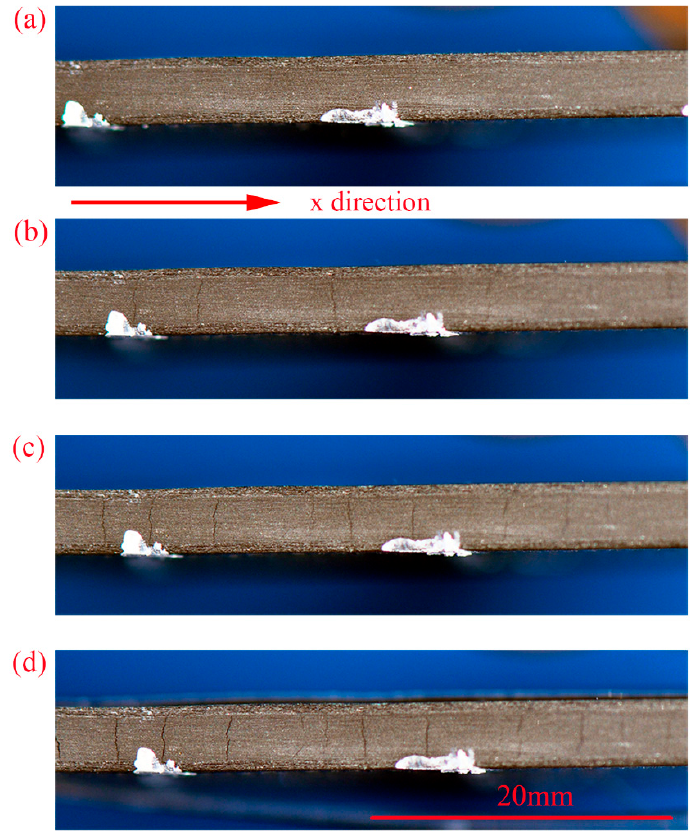
Figure 7. Photographs of transverse crack evolution of the [0 2 / 90 4 ] s laminate at di ff erent times during the test captured after 6000 N: ( a ) 0 s; ( b ) 120 s; ( c ) 240 s; ( d ) 360 s.